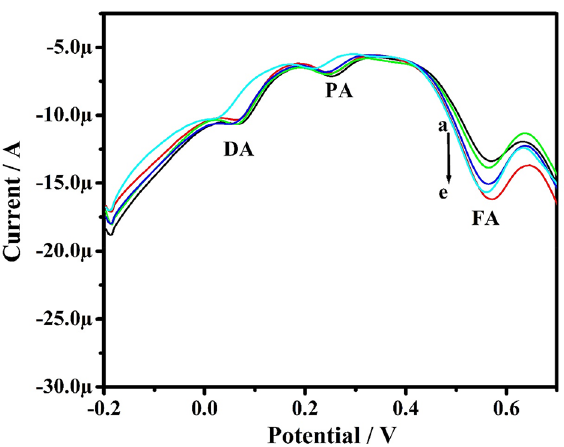
Figure 16. DPVs for FA at different concentrations (10–50 µM) in PBS (0.2 M, pH 7.4) at SR 50 mVs −1 at PoOCD/MCPE.